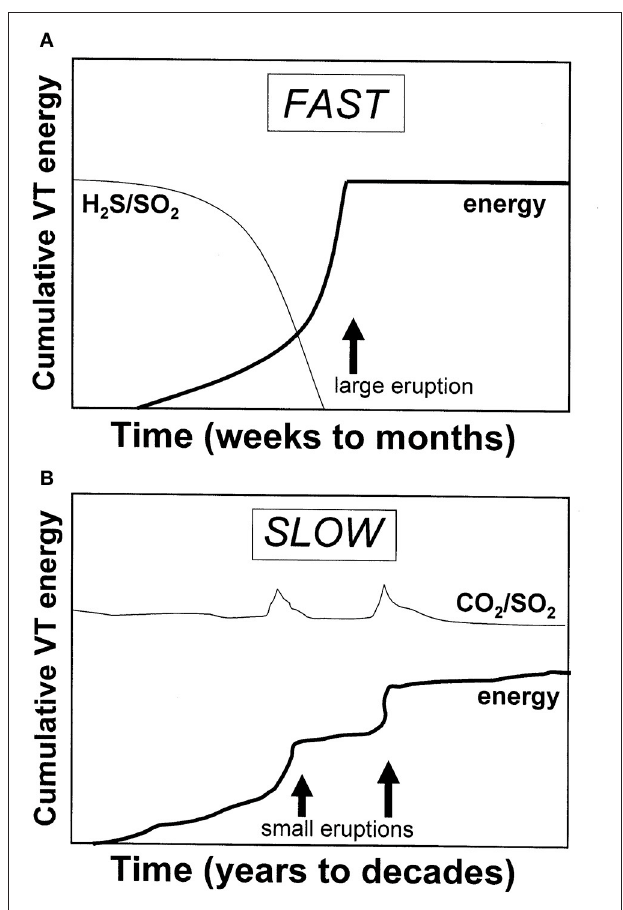
FIGURE 7 | Schematic representations of cumulative energy release of distal volcanotectonic earthquakes for fast and slow volcanic systems. Note the difference in scale for the horizontal axis between (A) (weeks to months) and (B) (years to decades). In (A) the H 2 S/SO 2 ratio of gases is plotted with the earthquake cumulative energy, while in (B) the CO 2 /SO 2 ratio of gases is plotted with the cumulative energy. Plot based upon work by White and McCausland (2016) and De Moor et al.